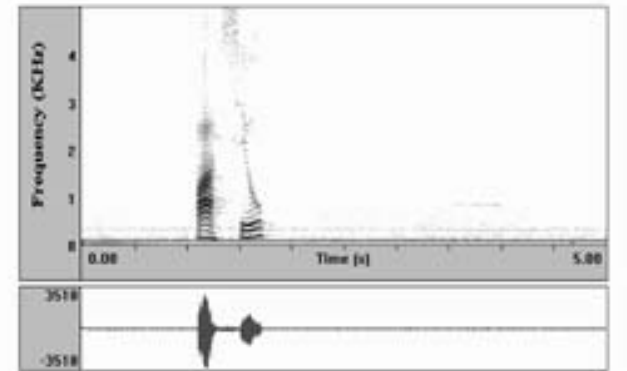
Figura 2a. Emissªo da palavra fÆcil pelo sujeito sem anartria. Cada mancha corresponde a uma s(cid:237)laba da palavra.